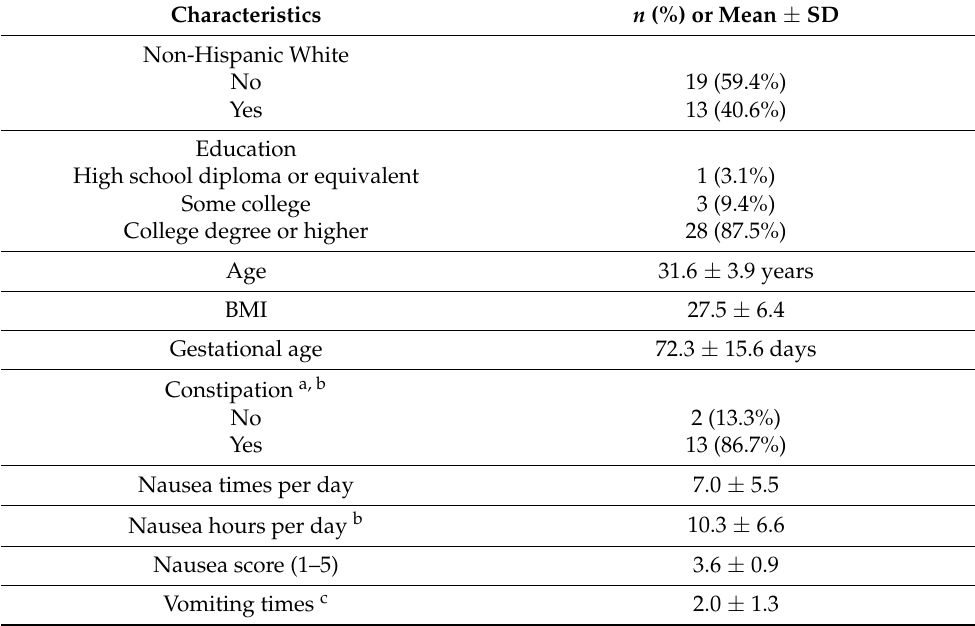
Table 1. Ages, BMI, gestation ages, and information related to nausea, vomiting, and constipation on day 0 for the ITT population. Table 1. Demographics and characteristics of the participants at enrollment ( n =